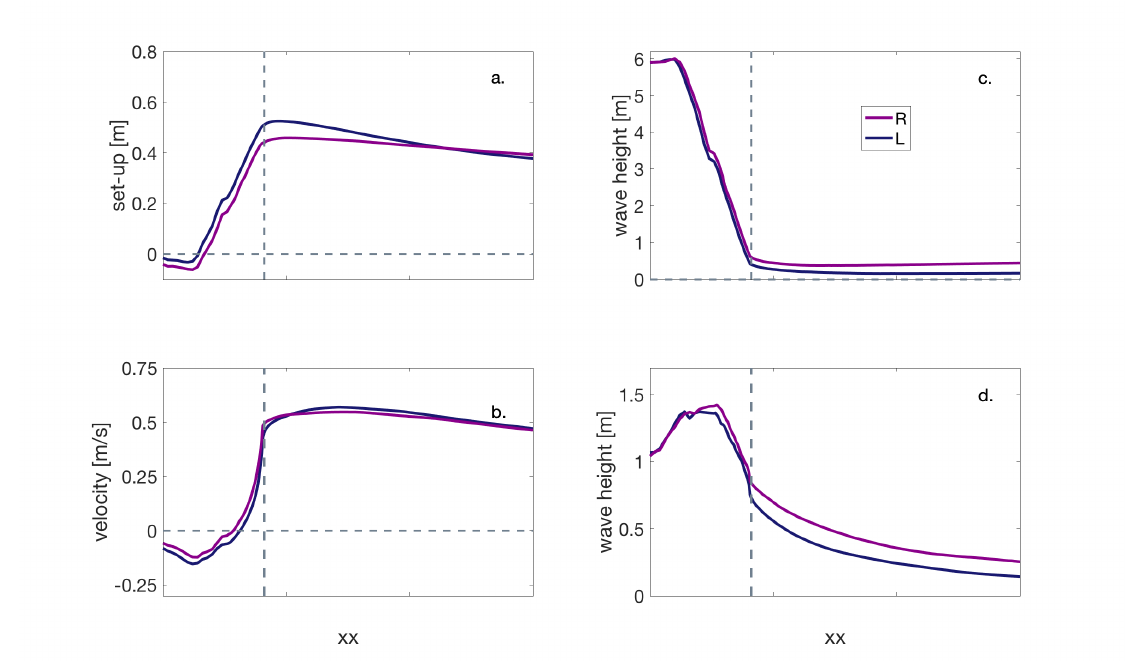
Figure 11. Predicted water level set-up (which includes higher water levels in the basin) ( a ), mean flow velocities ( b ), short- ( c ) and IG wave heights ( d ) for R and L . The x -axis is the normalized grid ( xx ) from the beginning of the seaward slopes ( xx = 0) to the back barrier basin ( xx = 3.7). Here, the slopes are the same (1:120) and output at all grid locations is in the same water depth. The vertical dashed line indicates the location of the